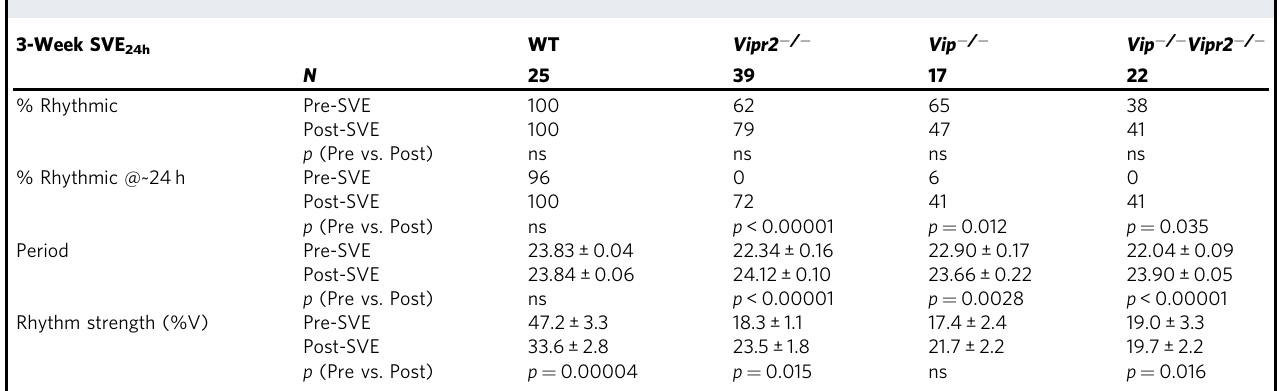
Table 1 Behavioral parameters for 3-week SVE experiment.